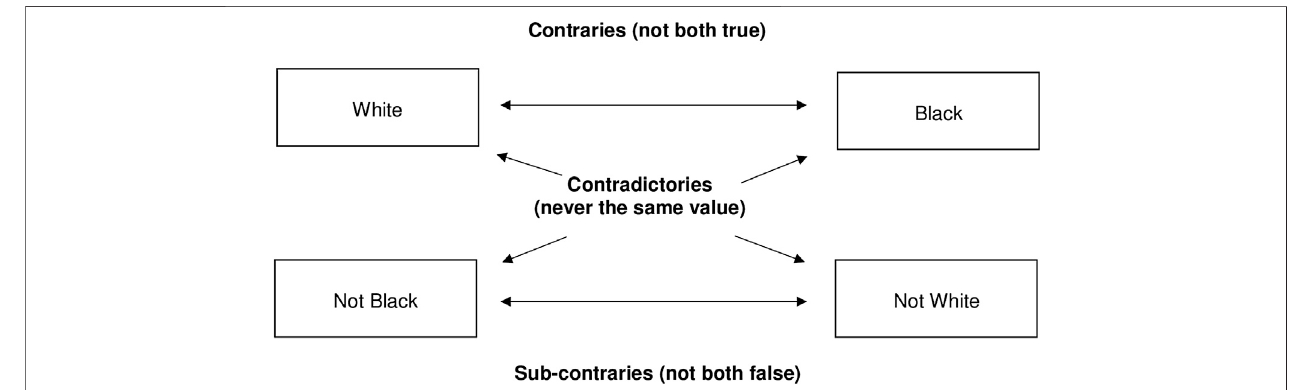
FIGURE 1 | Simple square of